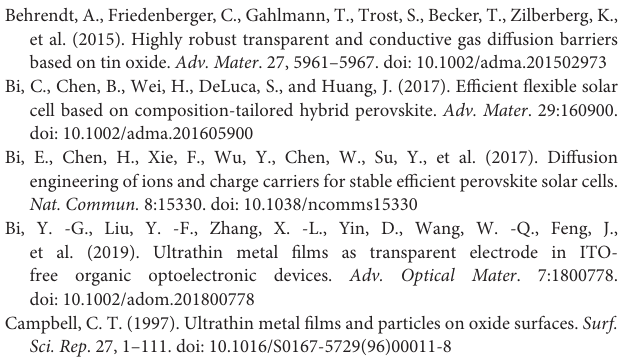
Maximum transmittance (T max ), sheet resistance (R s ) and safe bending radius (curvature radius at which the electrode can be repeatedly bended without degradation of the electrical properties) are